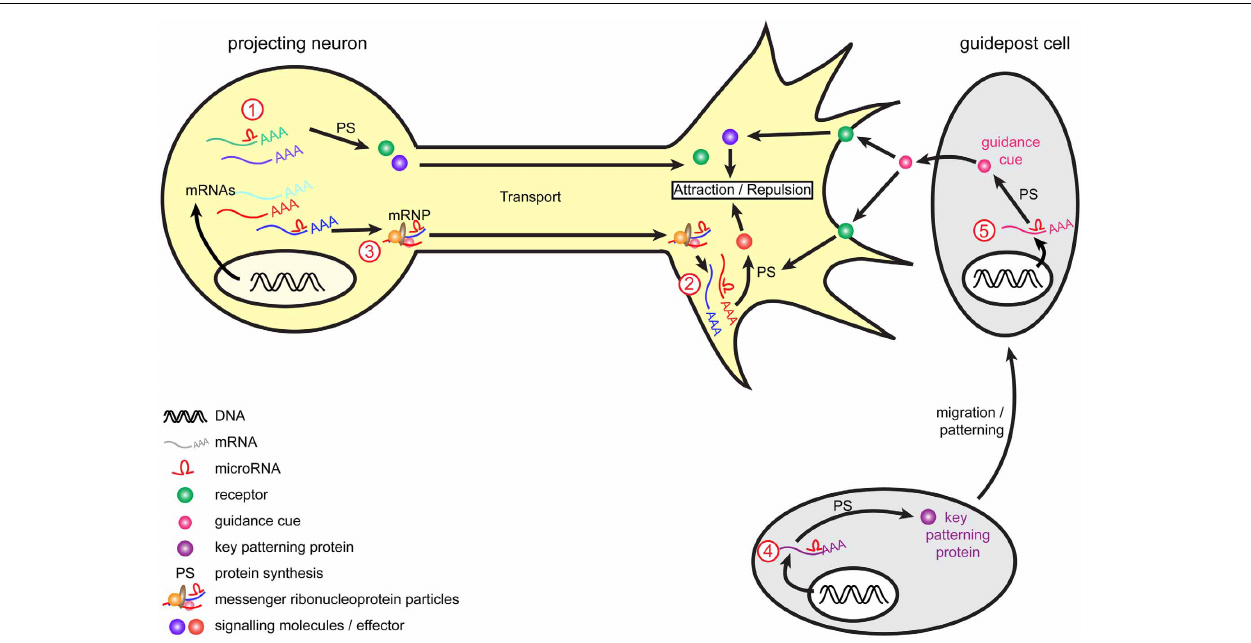
FIGURE 2 | Model of miRNA-mediated regulation of axon guidance. During pathfinding, tight regulation of mRNAs occurs to ensure protein expression of guidance molecules at the right time and place, and enable accurate growth cone steering. Within projection neurons, transcripts are translated into the cell body and are subsequently transported within the axon to the growth cone to mediate guidance cue-induced signaling. Alternatively, mRNAs associate into messenger ribonucleoprotein particles (mRNPs) to be transported to the growth cone, where they can be locally translated. Retrograde transport of transcripts from growth cones to cell soma also exists (not represented here). miRNAs are speculated to act at multiple level. They may regulate transcripts translation and stability (1) within the cell body as suggested for miR-124 and lin-4 (Baudet et al., 2012; Zhang et al., 2013) or (2)